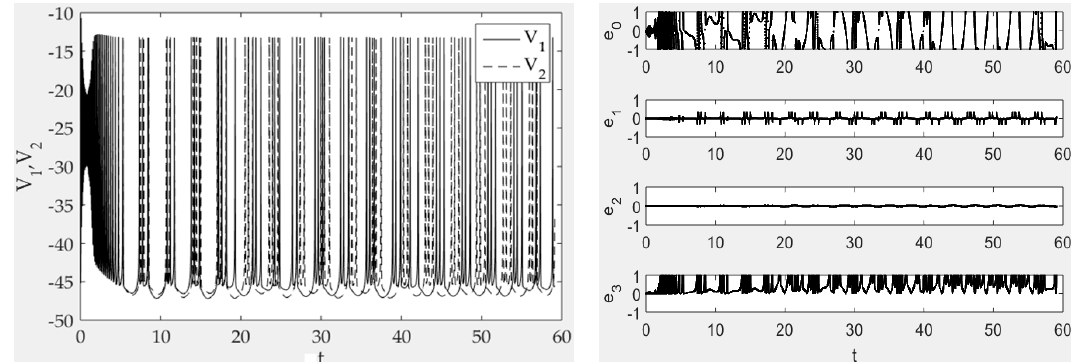
Figure 3. Time history diagram and synchronization discrepancy graph when H syn = 0.